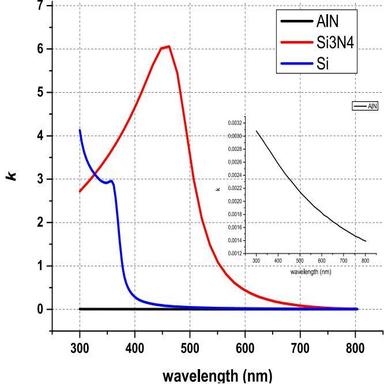
Extinction coefficients of AlN, Si3N4 and Si stack.